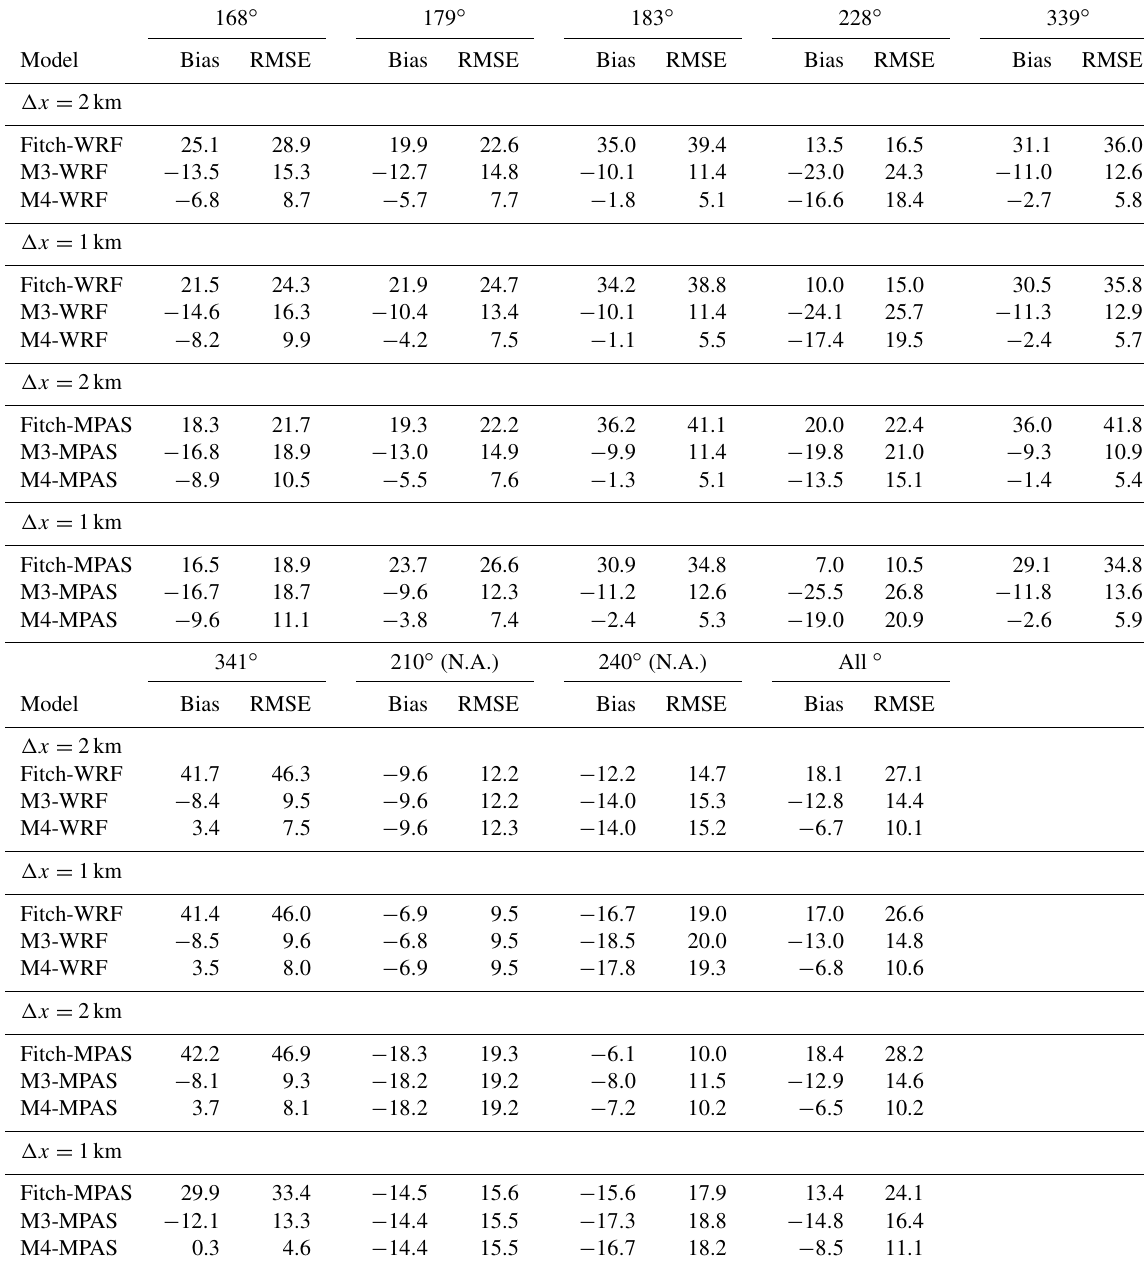
Table 4. As in Table 1 but at Anholt for multi-cell cases (in percent). The results are from WRF and MPAS. 168